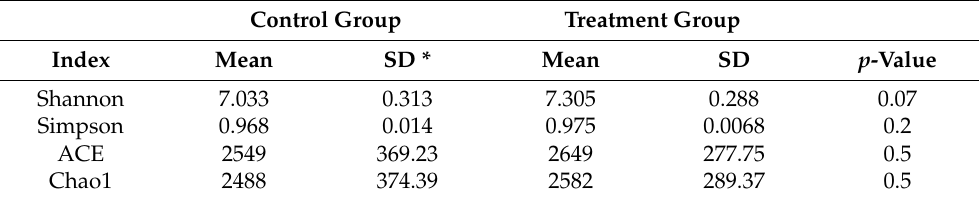
Table 1. Effects of dietary protected sodium butyrate supplementation on the microbial alpha diversity in the colon content of growing-finishing pigs.